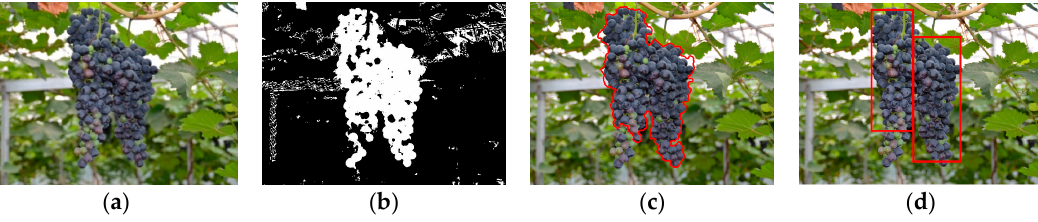
Figure 9. Detection process of one of the multiple overlapping grape clusters ( a ) Original image; ( b ) Initial segmentation image by the developed classifier; ( c ) The contour of the detected grape clusters; and ( d ) Detection result.